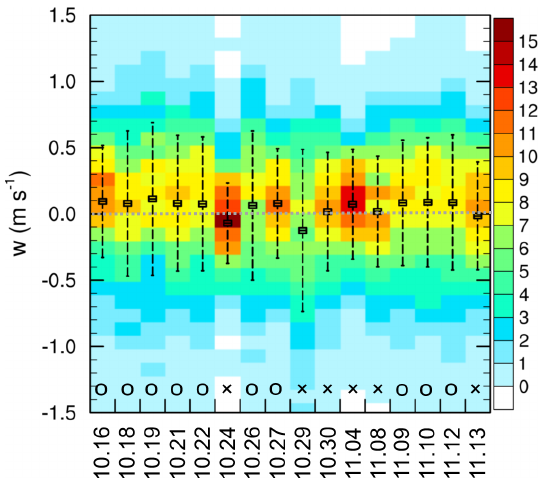
Figure 9. Probability distribution function (unit: %) of vertical ve- locity ( w ) for 16 non-drizzling flights. Black symbols are mean val- ues of w , and error bars through these symbols indicate the stan- dard deviation. Circles are the cases with typical well-mixed BL, and crosses represents the other